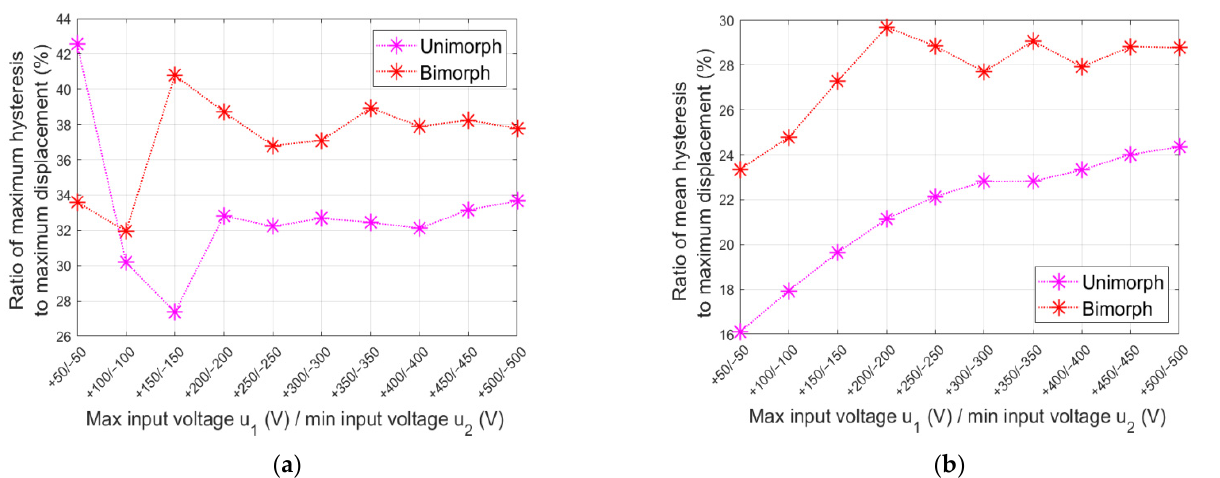
Figure 10. Ratio: ( a ) maximum hysteresis to maximum displacement of actuator beam tip, ( b ) mean value of hysteresis to maximum displacement of actuator. value of hysteresis to maximum displacement of